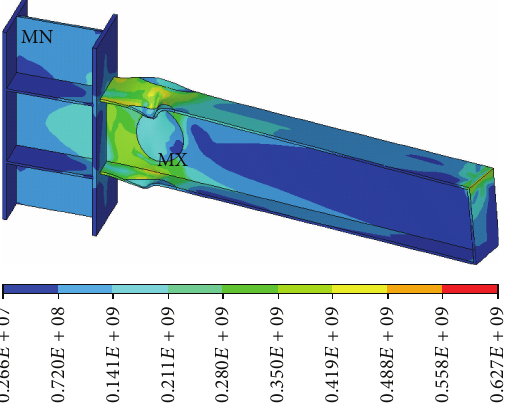
Figure 10: Stress of replaceable connection 4.